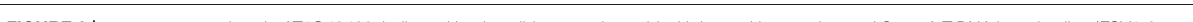
FIGURE 2 | non-sense mutations in AT1G42430 , indicated by the wild type amino acid with its position number and Stop. A T-DNA insertion line ( ESV1-2, GABI_031C11 ) was obtained from the stock center. Black bars: exons, Lines: introns, Numbers in black bars: exon number, Inverted triangle: T-DNA insertion site. (B) Restoration of endodermal starch granules in the ESV1 mutant via ectopic expression of ESV1 but not LESV . Endodermal starch granules were visualized by staining 3-day-old dark-grown seedlings with Lugol’s iodine. ESV1-2 : a T-DNA insertion mutant in AT1G42430 ( GABI-031C11 ), lesv-2 : a T-DNA insertion mutant in AT3G55760 ( Salk_006705 ), ESV1 -OX/ ESV1-2 : a transgenic line expressing ESV1 under the 35S promoter in the ESV1-2 mutant background, LESV -OX/ ESV1-2 : a transgenic line expressing LESV under the 35S promoter in the ESV1-2 mutant background. Scale bar = 100 µ m. (C) Restoration of hypocotyl gravitropism in ESV1 mutants via the ectopic expression of ESV1 but not LESV . Seedlings were grown for 3 days in the dark on horizontal plates and the degree of negative gravitropism was measured by quantifying the percentage of standing seedlings. Seedlings were counted as standing if their cotyledons did not touch the agar surface. Col-0: wild type, pifQ : pif1 pif3 pif4 pif5 mutant, ESV1-2 : a T-DNA insertion mutant of AT1G42430 ( GABI-031C11 ), lesv-2 : a T-DNA insertion mutant of AT3G55760 ( Salk_006705 ), lesv-3 : a T-DNA insertion mutant of AT3G55760 ( Salk_006697 ), ESV1 -OX/ ESV1-2 : transgenic plants expressing ESV1 under the 35S promoter in the ESV1-2